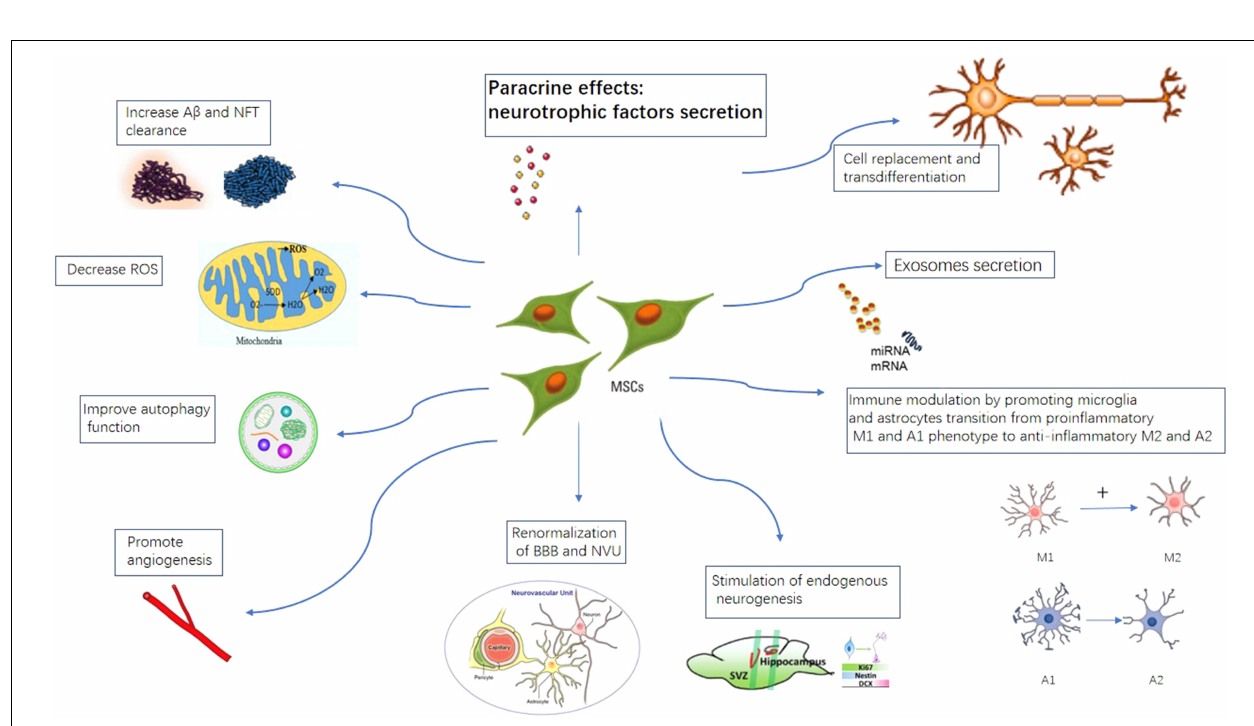
FIGURE 4 | Proposed mechanisms of MSCs therapy in AD. MSCs can take effects by cell replacement, paracrine effects, exosome secretion, immune-modulation, promote angiogenesis, stimulation of endogenous neurogenesis, increase A beta and NFT clearance, improve autophagy, renormalization of blood–brain-barrier.